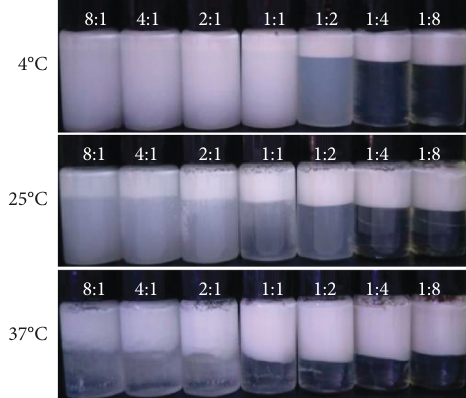
Figure 4: Photographs of pH 5.0 BSA-WSC emulsions (containing 5% v/v oil) with different biopolymer ratios ( R � BSA :WSC � 8: 1–1 :8) after 20-day storage at (a) 4 ° C, (b) 25 ° C, and (c) 37 ° C.